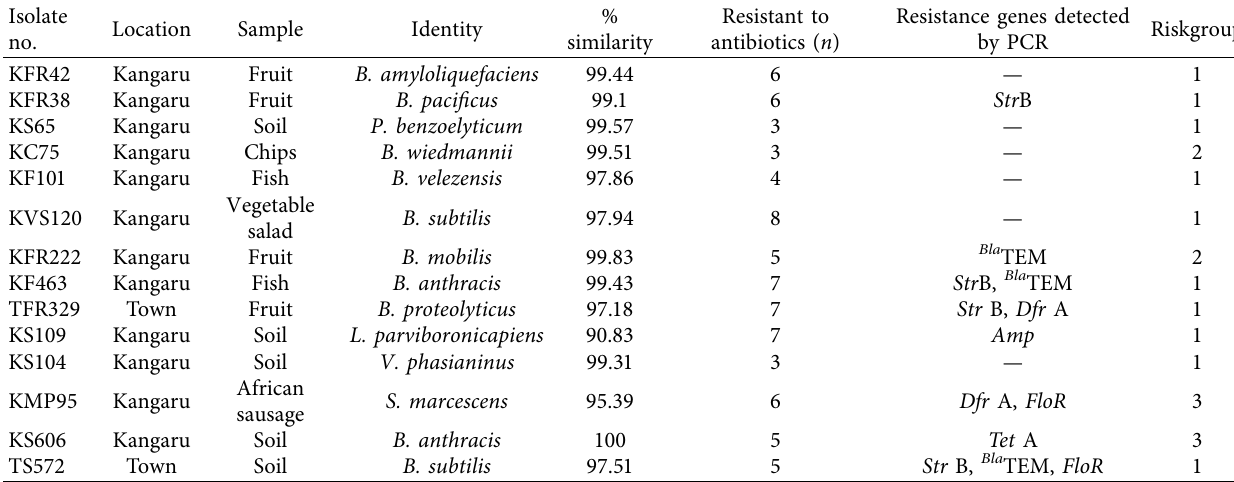
Table 5: Risk groups of antibiotic-resistant bacteria isolated from vended foods and soil in Embu Town and Kangaru Market. Isolate